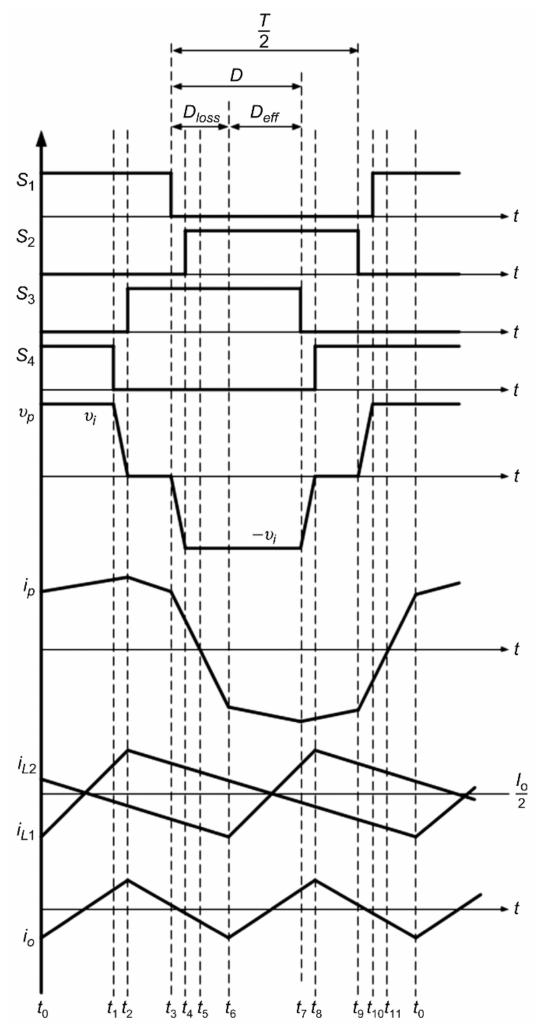
Figure 7. Key waveforms of the proposed